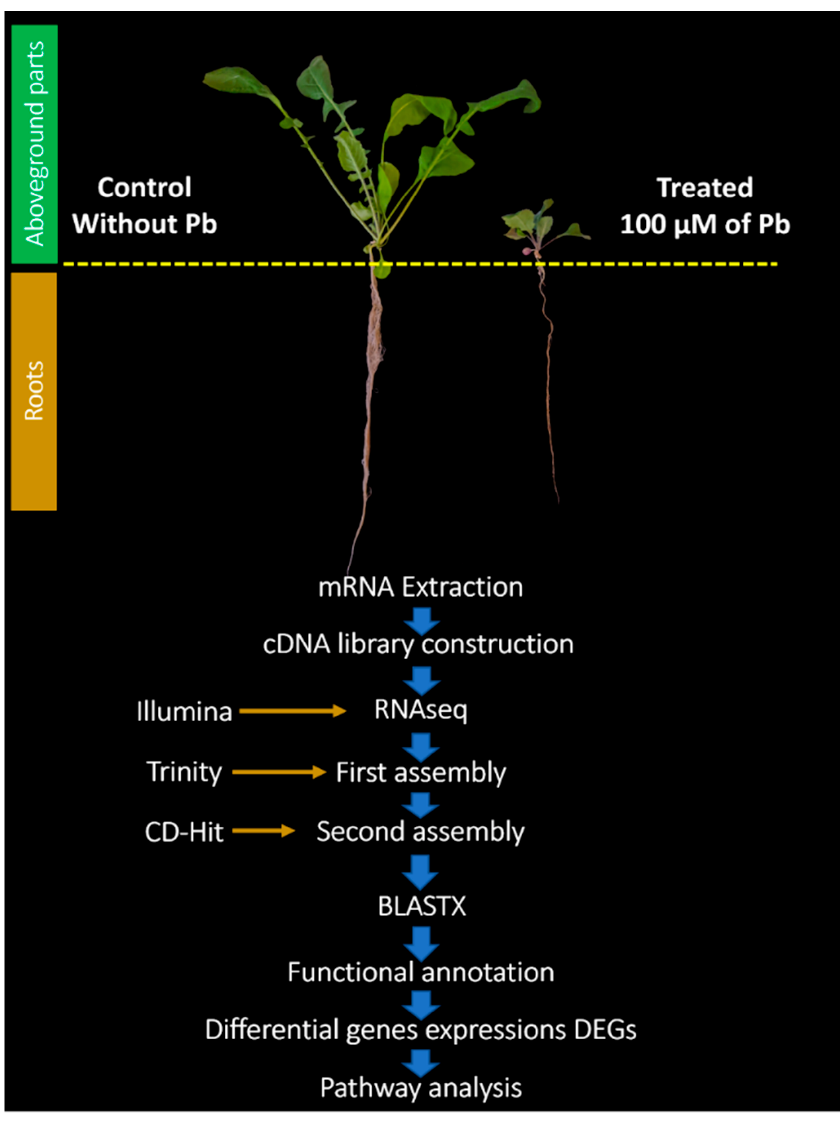
Figure 1. Experimental design for RNAseq and pipeline.